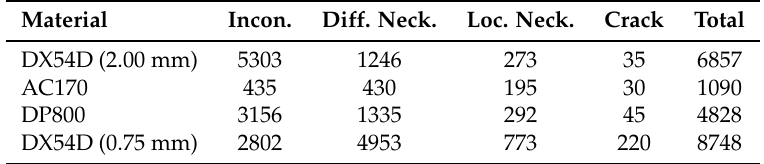
Table 1. Amount of available images per failure class–sum over all geometries per material. Material